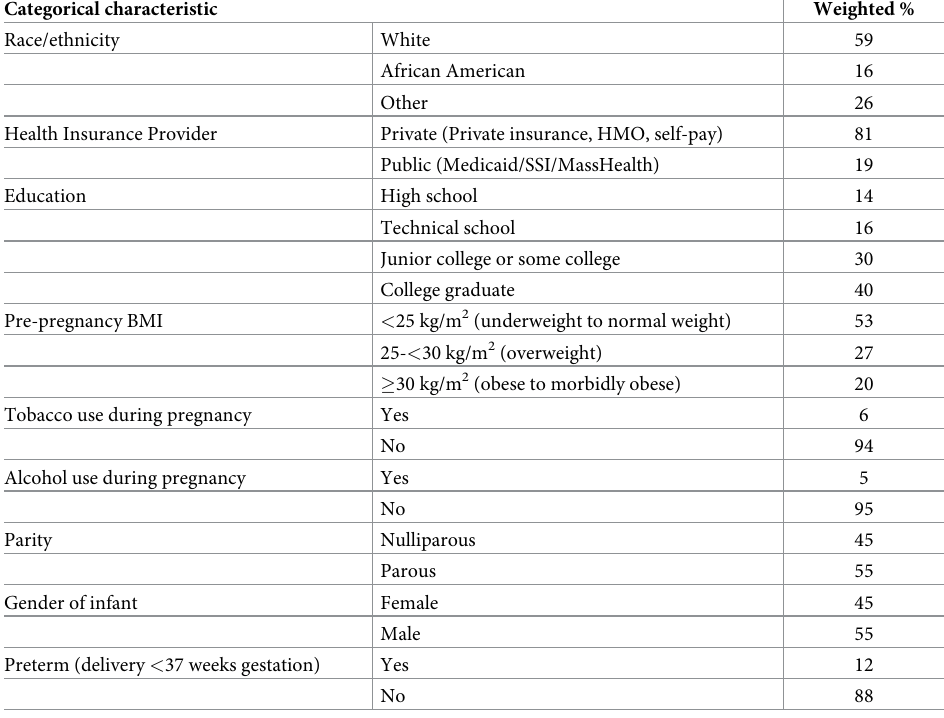
Table 1. Demographic characteristics of weighted study population (N =